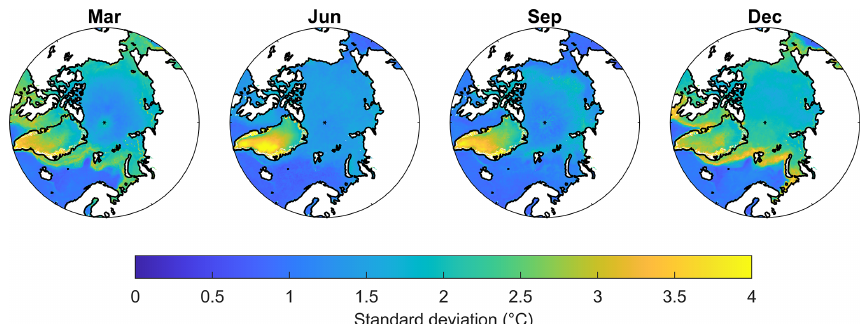
Figure 4. Standard deviations ( ◦ C) of daily satellite surface temperature observations for March, June, September, and December of each year averaged for the years